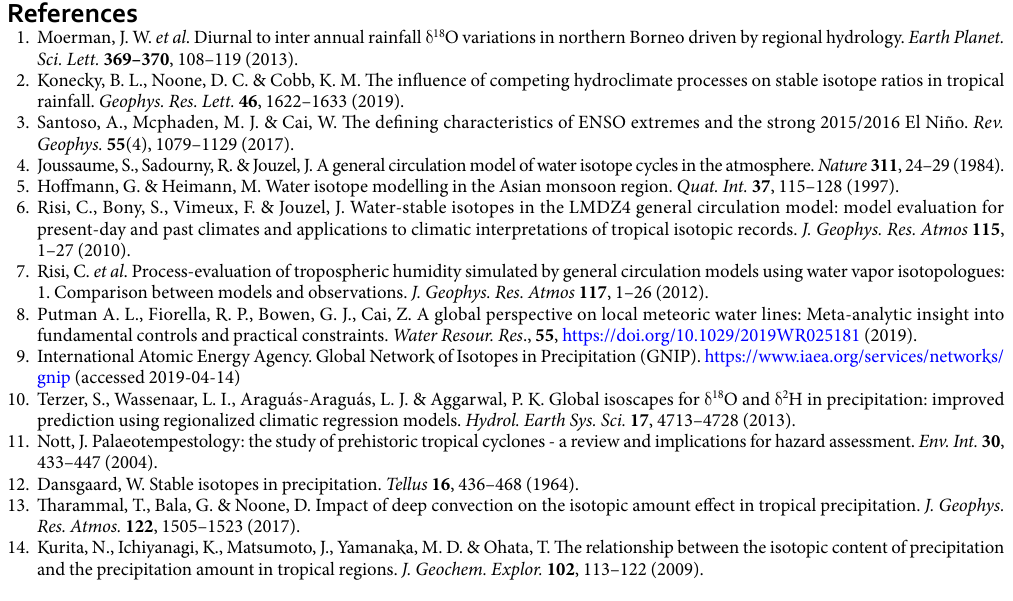
ensure analytical accuracy and optimise quality control procedures. Most of the CRP’s laboratories participated in the IAEA Water Isotope Inter-Comparison WICO2016 36 as well as an unofficial CRP-wide inter-comparison. Data Records Data sets are available at figshare.com (https://figshare.com/s/fdfabb43a844cad530a5). The file ‘CRP isotopes’ contains stable isotope data in daily rainfall at 19 stations sampled within the period 2012 to 2017. They are recorded in the following order: Local sampling start date/time (YYYY-MM-DDTHH:MM), local sampling end date/time (YYYY-MM-DDTHH:MM), precipitation δ 18 O (‰ VSMOW), precipitation δ 2 H (‰ VSMOW), pre- cipitation d -excess (‰ VSMOW), precipitation amount (mm). Note that at some stations only the sampling end date was recorded (sampling of 24-hr rainfall occurred at 9:00 local time). Empty cells indicate that no data was obtained. The file ‘CRP stratiform P’ contains calculated stratiform precipitation area fraction for the subset of 14 sta- tions for which this fraction could be calculated (five stations were excluded, see above). They are recorded in the following order: Local sampling start date/time (YYYY-MM-DDTHH:MM), local sampling end date/time (YYYY-MM-DDTHH:MM), sampled precipitation amount (mm), precipitation δ 2 H (‰ VSMOW), precipita- tion δ 18 O (‰ VSMOW), precipitation d -excess (‰ VSMOW), satellite observation date (YYYY-MM-DDT), daily mean area-averaged precipitation amount (mm), daily mean stratiform precipitation area-fraction, moving 10-day average precipitation δ 18 O (‰ VSMOW), moving 10-day average stratiform precipitation area-fraction. Stratiform rainfall area fractions < 0.01 were disregarded due to their high uncertainty. Empty cells indicate that no data was obtained.